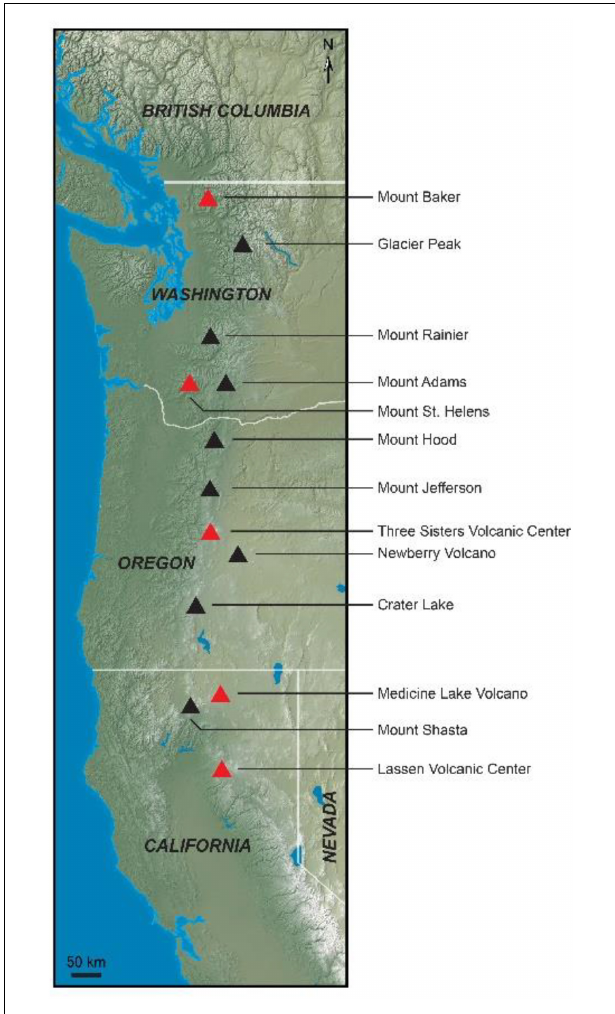
FIGURE 2 | Map of the major volcanic centers in the U.S. portion of the Cascade volcanic arc. Red colors indicate volcanoes where deformation has been detected. Modified from Poland et al. (2017).